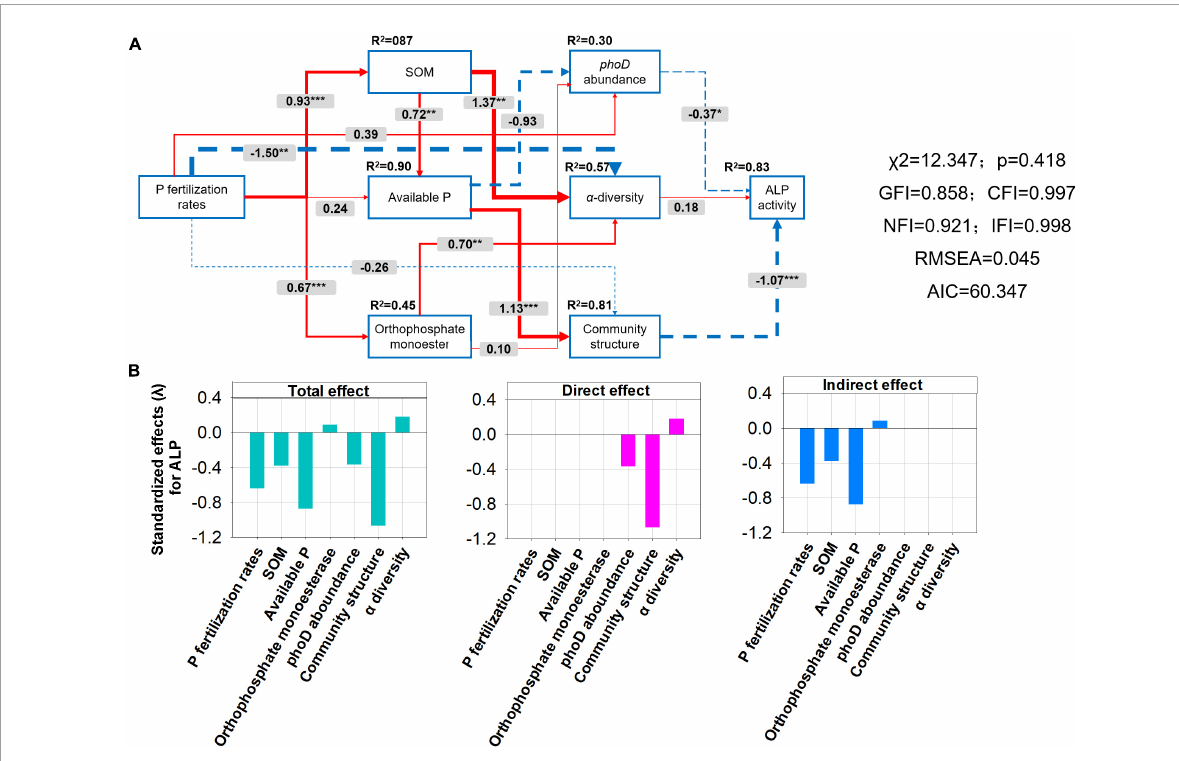
FIGURE9 Structural equation model (SEM) (A) and bar plots of effect values (total, direct, indirect) on alkaline phosphatases (ALP) activity (B) showing the influence of various factors on the correlationship among soil properties [including soil organic matter (SOM), available P (AP), and orthophosphate monoesters (OM)], alpha diversity, phoD abundance, community structure, and ALP activity of soil under long-term gradient phosphorus fertilization rates. The width of the arrow indicates the strength of the causal effect. The red and blue arrows indicate the positive and negative relationships between the indicators. The number above the arrow indicates the path coefficient. “*”, “**”, and “*” represent significant path. The percentage above each indicator represents the R 2 value, which is the variance-explained ratio of each variable. The final model fits the data well. The model is: ( χ 2 = 13.343, df = 1.026, CFI = 0.997, IFI = 0.997, RMSEA < 0.043, AIC =